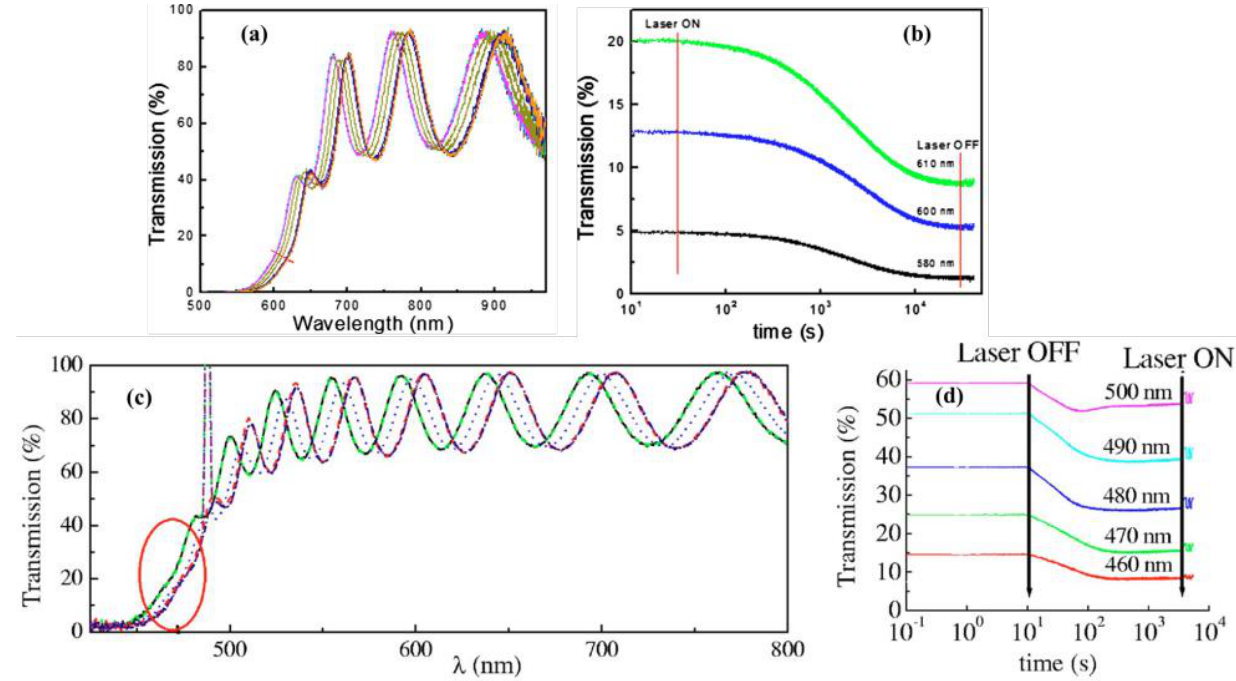
Figure 1. ( a ) Optical transmission spectra of a-As 2 Se 3 thin films for laser intensity of 10 mW/cm 2 ; the red arrow depicts the redshift in in transmission spectra. ( b ) Time evolution of transmission at 580, 600, and 610 nm for the intensity 10 mW/cm 2 . All Figures are reprinted with permission from [26] Copyright 2009, American Institute of Physics. ( c ) Transmission spectra for a-As 2 S 3 films is as-prepared (line), illuminated (at time t = 1 s (thick dashes), 60 s (dots), 3600 s (red dash-dots) and post-illuminated (thin dashes)) state. The transmission spectrum is recovered between switch off (blue dash-dots) and switch on (long-short dashes) state of laser illumination. ( d ) Time evolution of transmission at fixed wavelengths. All Figures are reprinted with permission from [13] Copyright 2006, American Physical Society.